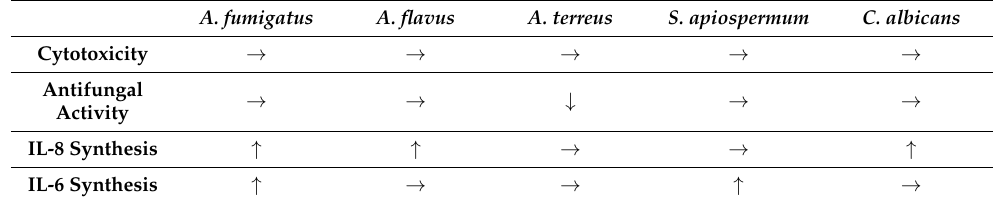
Table 1. Impact of P. aeruginosa flagellin pre-exposure on the inflammatory and antifungal responses of BEC subsequently infected with different fungal pathogens. → no impact; ↑ increased response; ↓ decreased